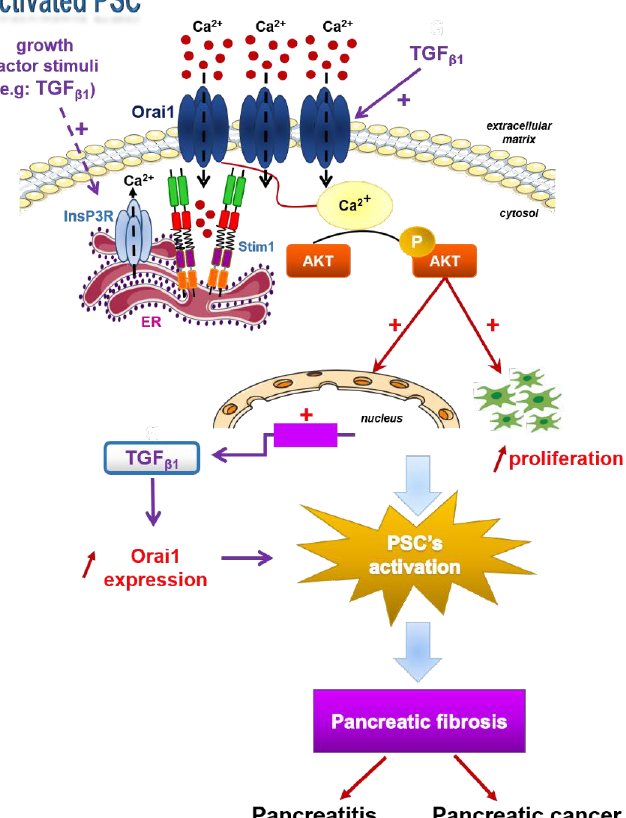
Figure 8. Conclusive scheme: Endoplasmic reticulum Ca 2+ store depletion activates Orai1 channel permitting SOCE. Ca 2+ entry through Orai1 activates AKT phosphorylation, which stimulates human-activated PSC proliferation and TGF β1 expression and secretion, enhancing PSC activation to promote pancreatic fibrosis, and so pancreatitis and pancreatic cancer. In turn, TGF β 1 secretion stimulates Orai1-mediated Ca 2+ entry by simultaneously increasing Orai1 mRNA and protein expression in order to stimulate Orai1/AKT-dependent proliferation, maintaining PSC